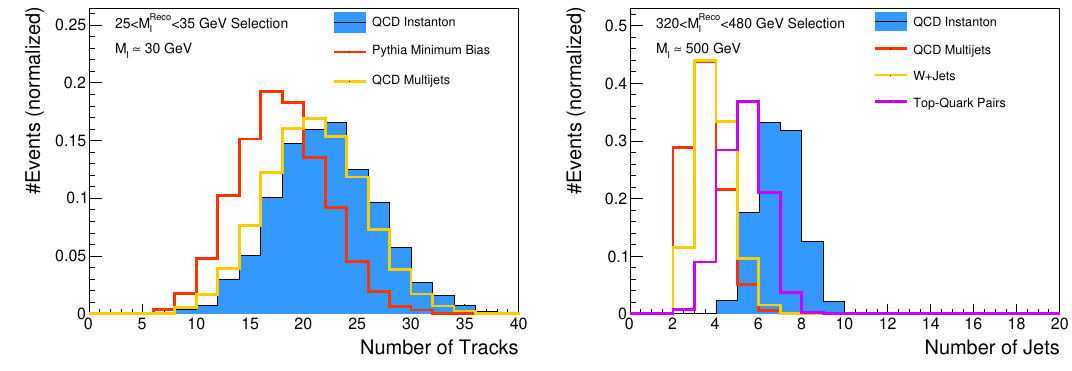
Figure 8 . Normalized distribution of the number of reconstructed tracks for events with 25 < M reco < 35 GeV (left) and of reconstructed particle-jets for events with 320 < M reco I (right). Beside the signal processes, the expected distributions of the background processes are shown (see table 3).